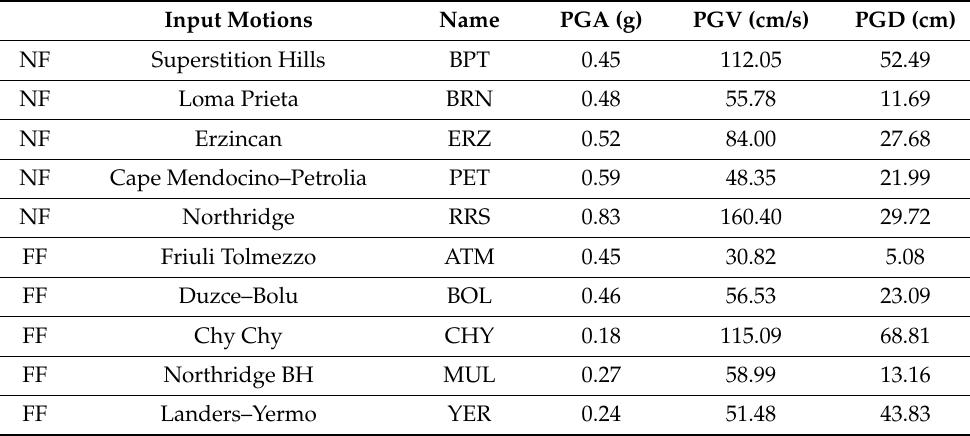
Table 7. Input motion